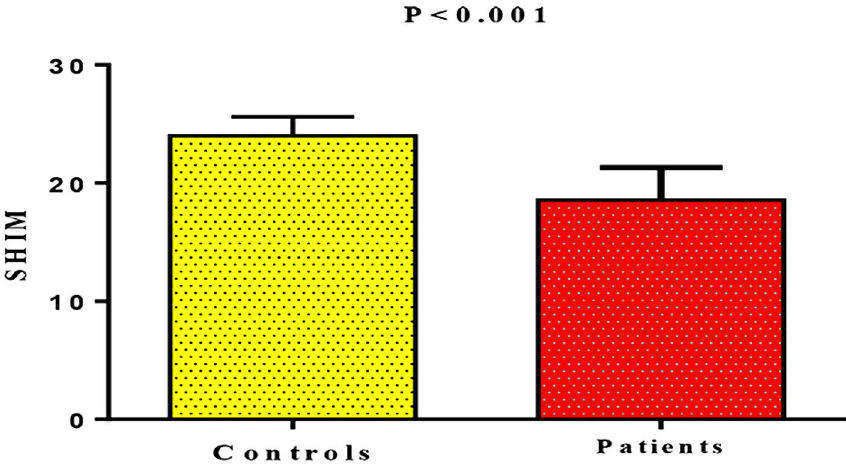
Figure 3. SHIM in post-COVID-19 patients with ED compared with